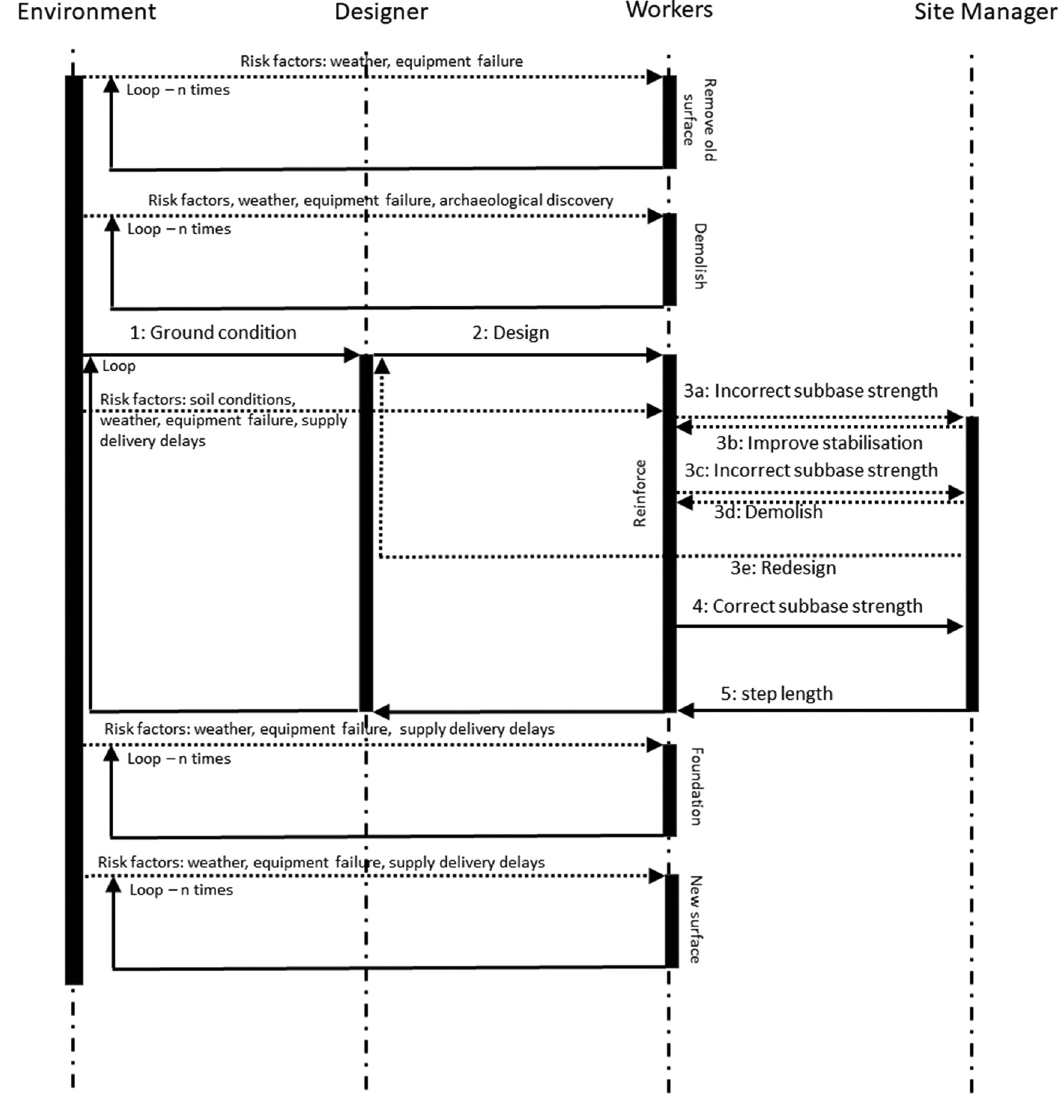
Figure 5: Sequence diagram of the agent - based model in